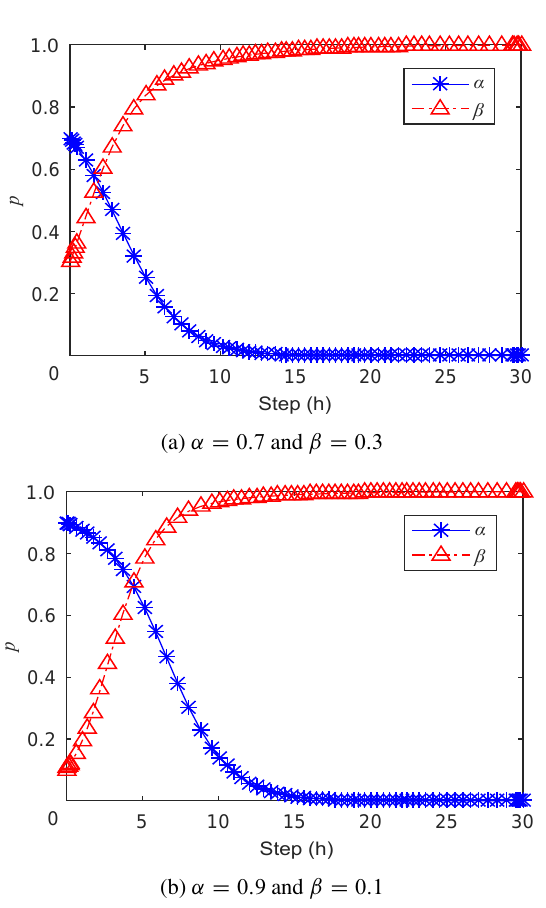
Fig. 3 Probability variation trend in the dissemination process of public opinion in Scenario 2.